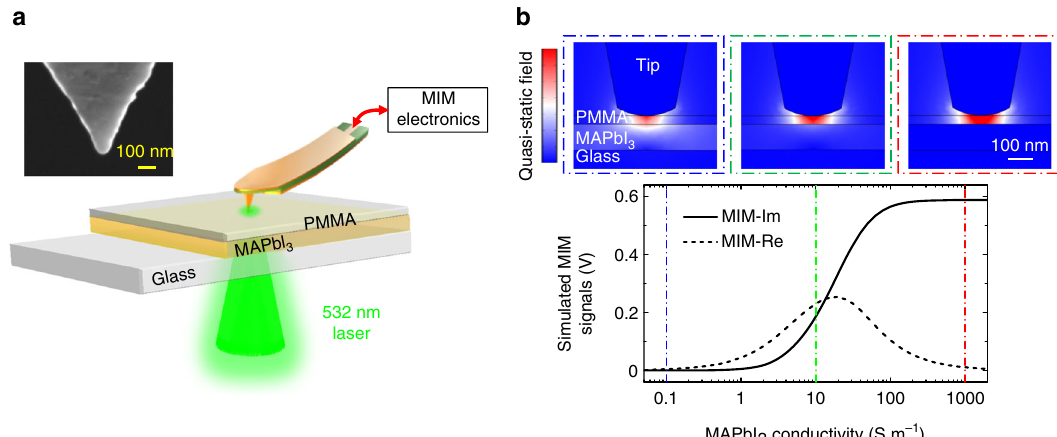
Fig. 1 Experiment setup and fi nite-element analysis. a Schematic diagram of the sample and the MIM setup with bottom illumination through the transparent glass substrate. Scanning is accomplished by moving the sample stage while fi xing the laser beam and the probe tip, which are aligned before the experiment. The inset shows the scanning electron microscopy (SEM) image of a typical MIM tip. b Simulated MIM signals as a function of the MAPbI 3 conductivity σ . The quasi-static displacement- fi eld distributions when σ is equal to 0.1, 10, and 1000S m − 1 are displayed inside the blue, green, and red dash-dotted boxes,